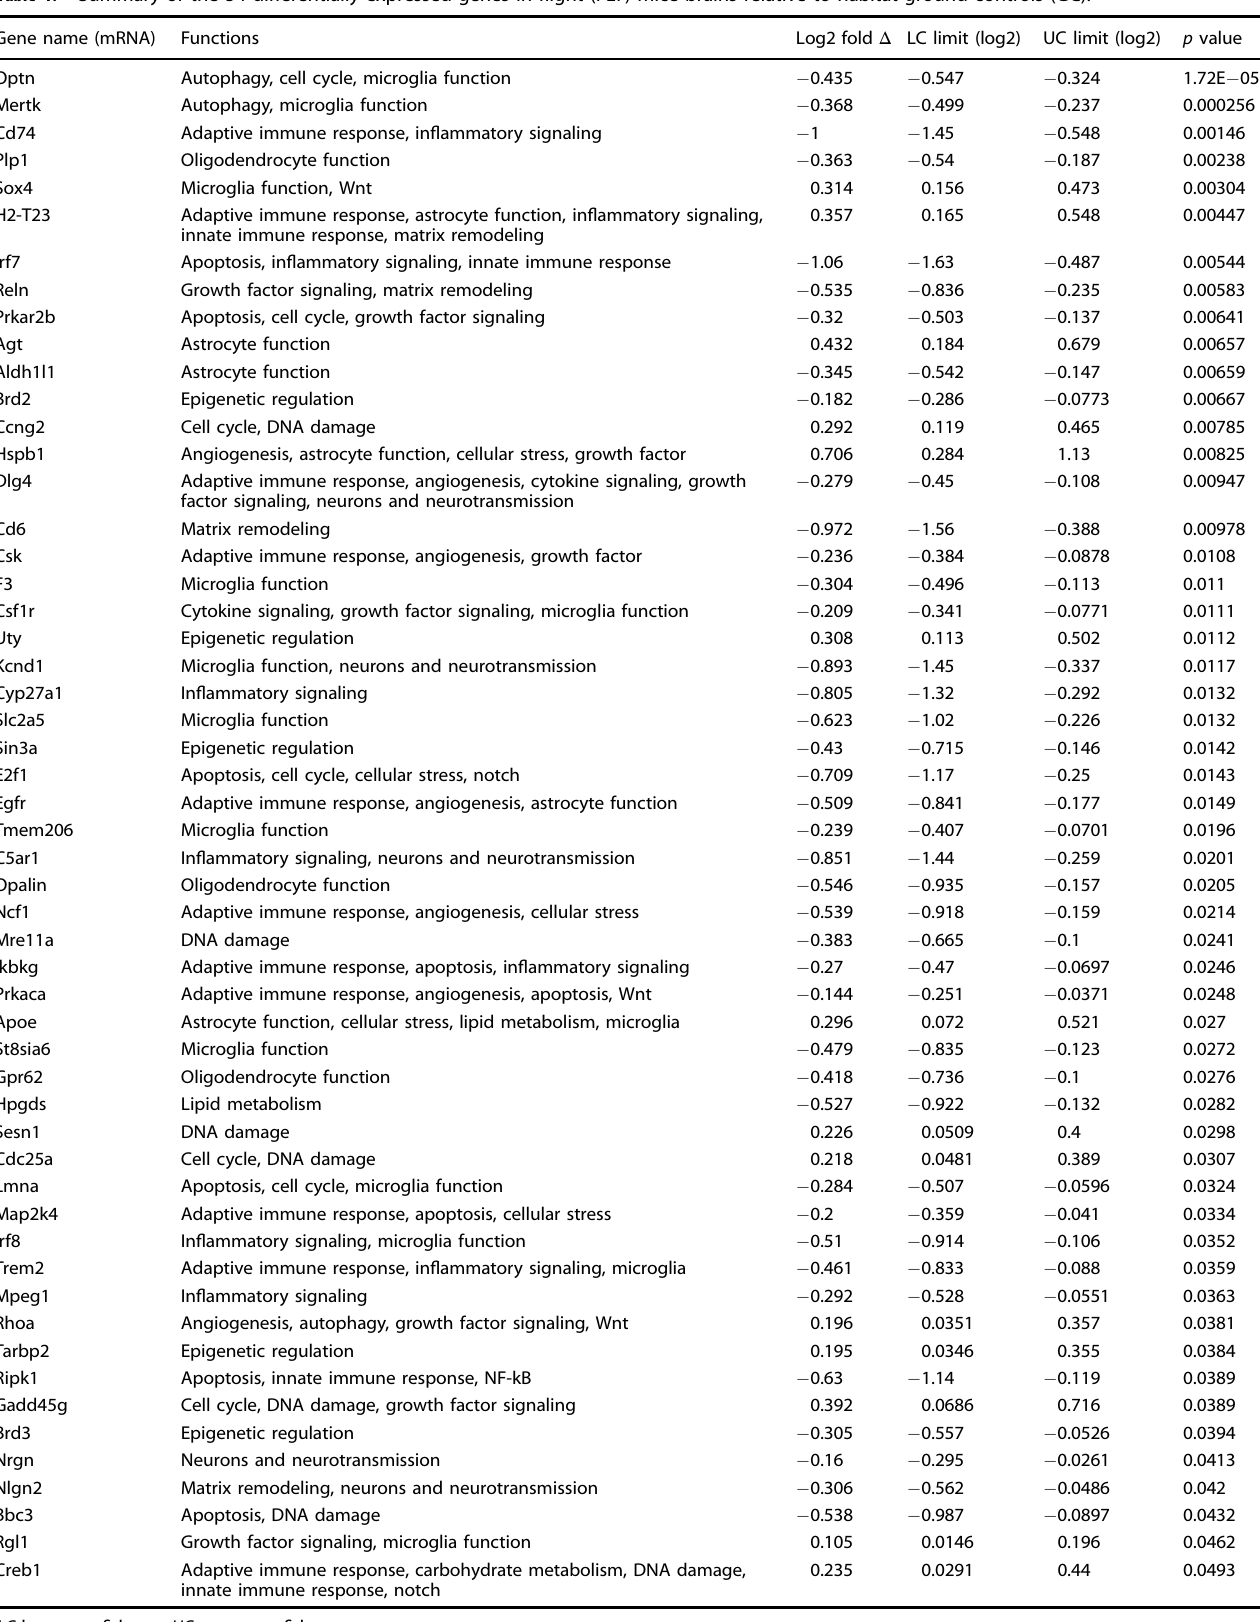
Table 1. Summary of the 54 differentially expressed genes in fl ight (FLT) mice brains relative to habitat ground controls (GC). Gene name